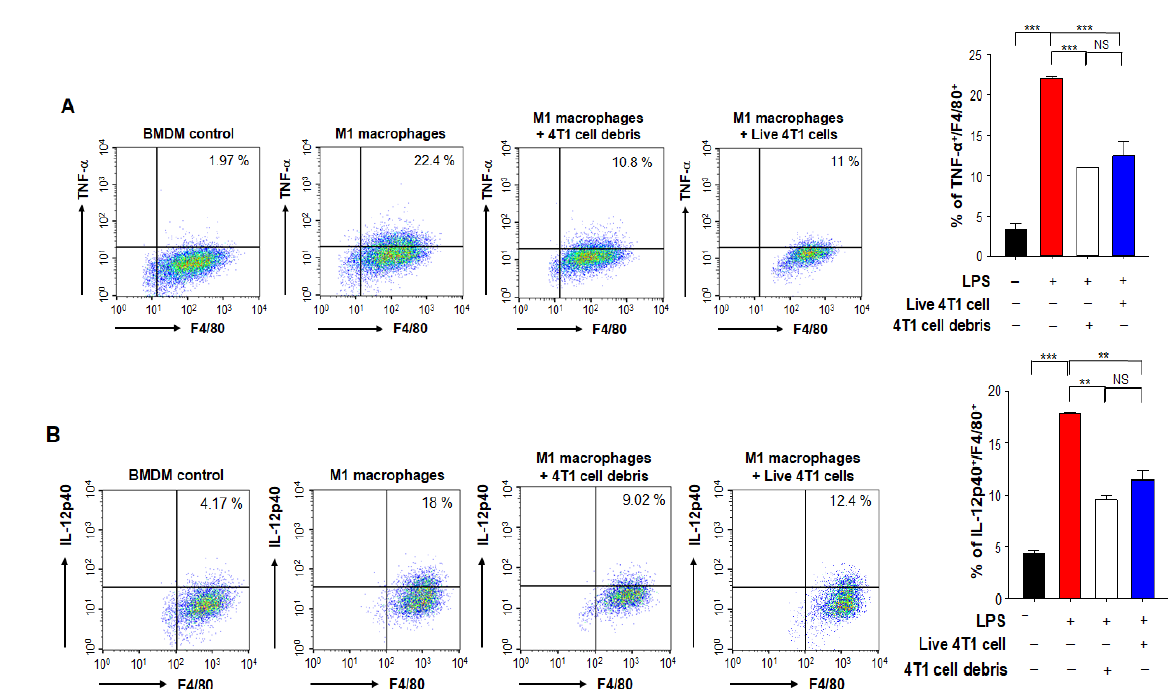
Figure 2. Effects of PTX-generated breast tumor cell debris on macrophage polarization. Murine BMDMs and live 4T1 breast cancer cells or those killed by PTX treatment were co-cultured for 24 h. After co-culture, t he proportions of macrophages expressing TNF- α ( A ) and IL-12p40 ( B ) were analyzed by flow cytometry. **, *** Significantly different between groups compared (** p < 0.01; *** p < 0.001). NS; not significant.